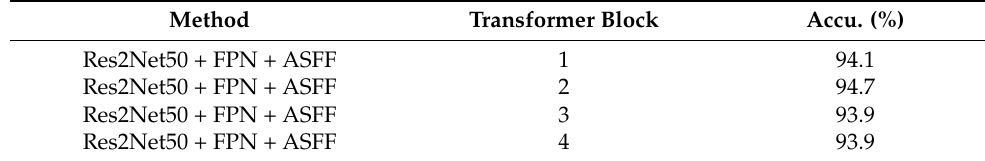
Table 4. Comparison of identification results with different swin transformer-coding